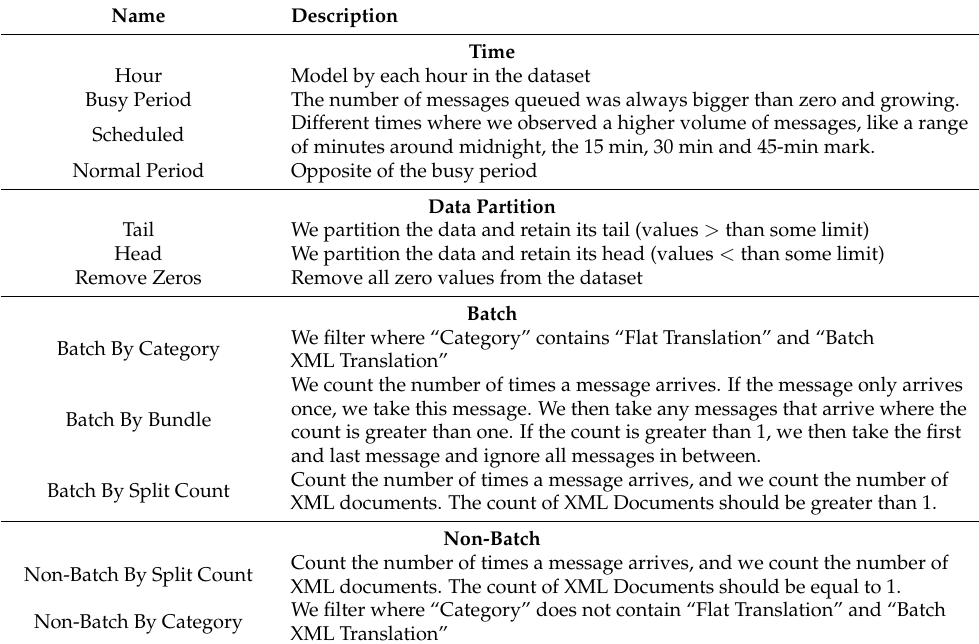
Table 6. Message classification data dictionary.